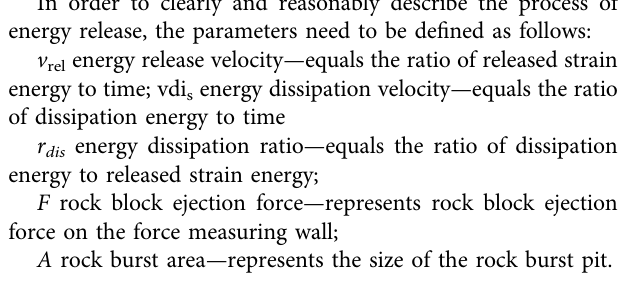
Frontiers in Earth Science |